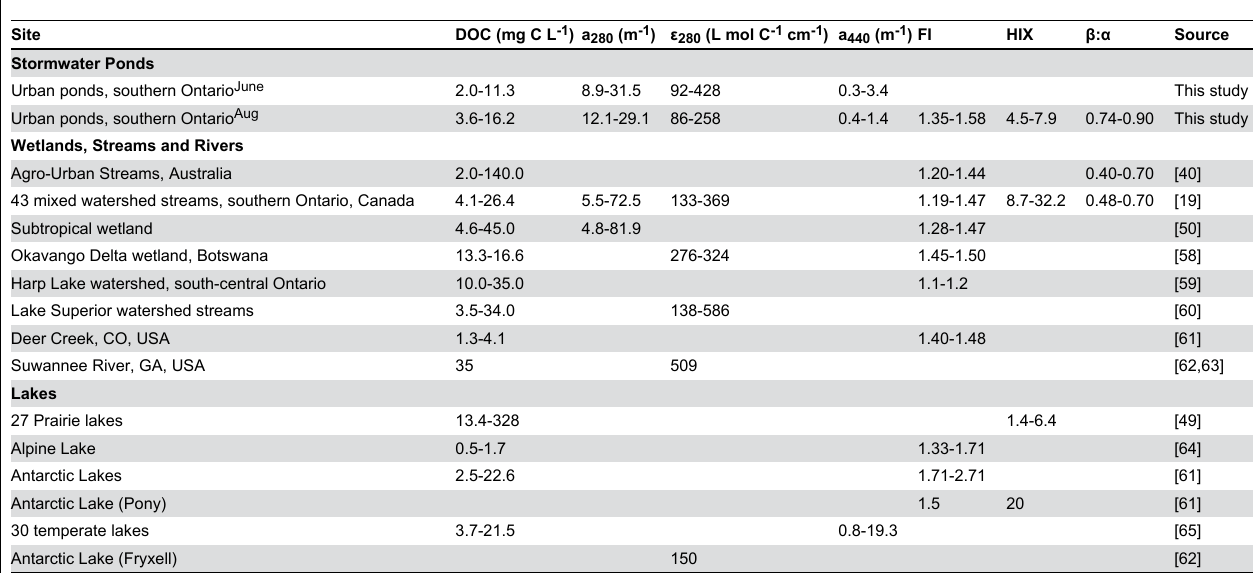
Table 2. Range in DOC concentrations, molar absorptivity at 280 nm (ε 45 urban ponds in June and August,